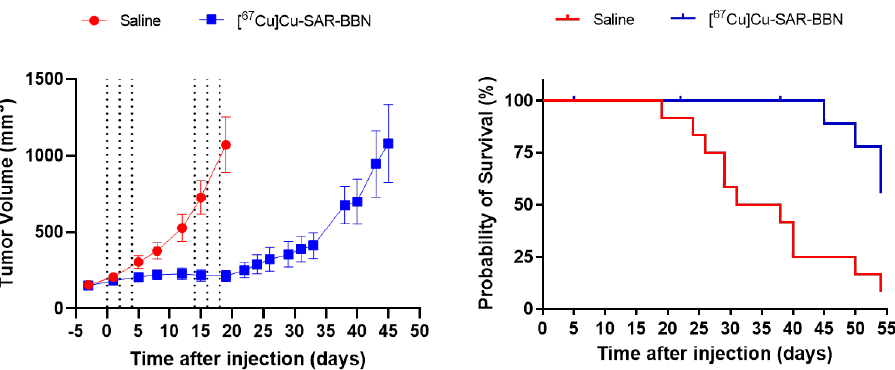
Figure 4. Inhibition of PC-3 tumor growth and Kaplan–Meier survival curve following treatment with 144 MBq [ 67 Cu]Cu-SAR-BBN over 3 weeks, expressed as mean tumor volume ( ± SEM) ( n = 12). On the left, the graph depicts average tumor volumes measured three times a week with the dotted lines indicating administration of either saline or 24 MBq [ 67 Cu]Cu-SAR-BBN on day 0, 2, 4, 14, 16, and 18 of the experiment. Tumor volume was calculated as length (mm) × width (mm) × width (mm)/2. The curves illustrate tumor measurements up to the last day of all mice alive for the saline (day 19) and [ 67 Cu]Cu-SAR-BBN (day 45). The right graph shows the survival curves of the saline (red) and [ 67 Cu]Cu-SAR-BBN groups as mice were euthanized due to tumor exceeding the volume of 2500 mm 3